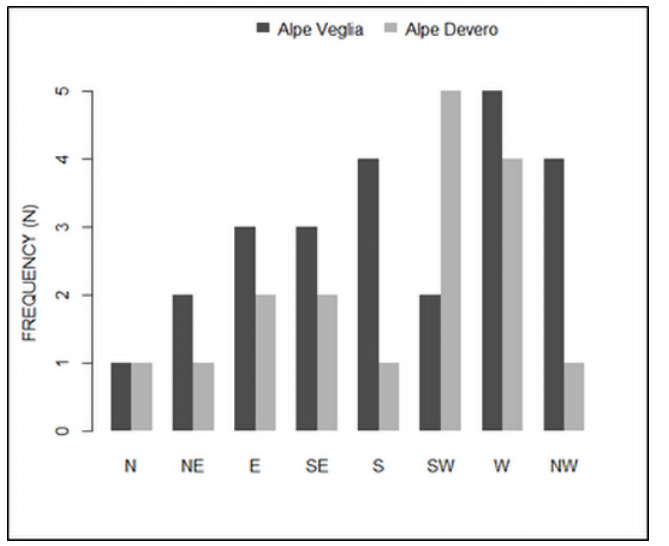
Figure 5 Frequency of host trees by